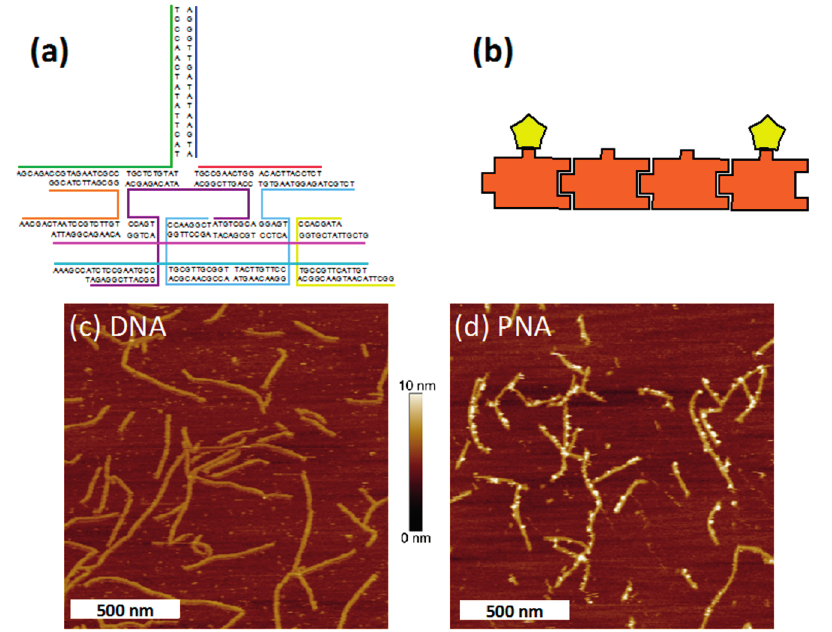
Figure 3. ( a ) Structure and sequence of the TX tile. The top protruding duplex provides a site for strand invasion of complementary PNA; ( b ) Schematic drawing of four TX tiles assembled into a linear array by sticky-end cohesion. Visualization of PNA3K invasion was achieved by incubating the arrays with biotinylated PNA3K (bPNA3K) and then with streptavidin (SA) since bound SA can be imaged by AFM. In this arbitrary example, SA protein (yellow pentagons) is shown bound to the first and last tiles in a four-tile array with the middle two binding sites shown unoccupied; ( c ) AFM image of TX arrays incubated with biotinylated DNA in 1 mM MgCl 2 . No SA is visible on the arrays, indicating that no binding of the biotinylated DNA occurred; ( d ) AFM image of TX arrays incubated in buffer containing 1 mM MgCl 2 , bPNA3K, and SA. Bound SA is observed, indicating successful strand invasion by PNA3K into the DNA duplexes on the DNA